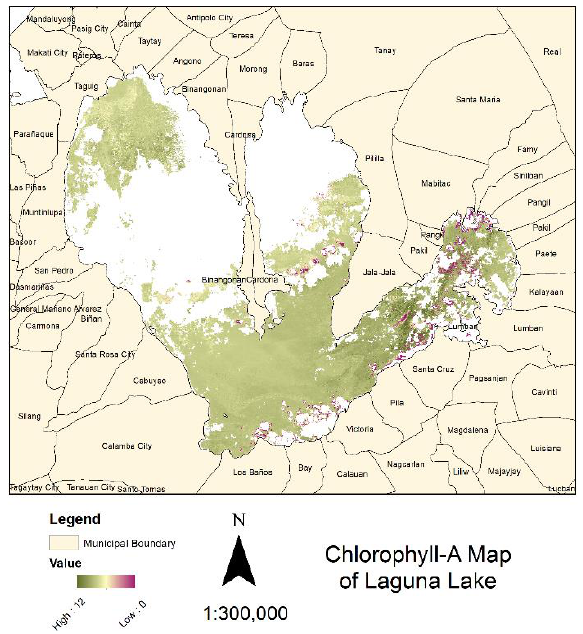
Figure 8. Chlorophyll-a map output from Landsat 8 processing in